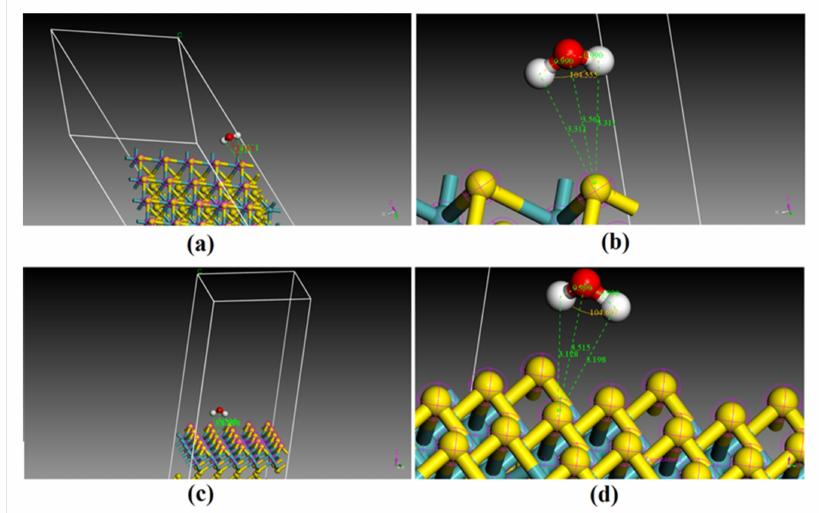
Figure 8. Geometry of the two most stable adsorption sites for H 2 O on the (001) surface: ( a , b ): 001-G1; ( c , d ): 001-G2 (yellow ball represents sulfur atom; blue ball represents molybdenum atom).